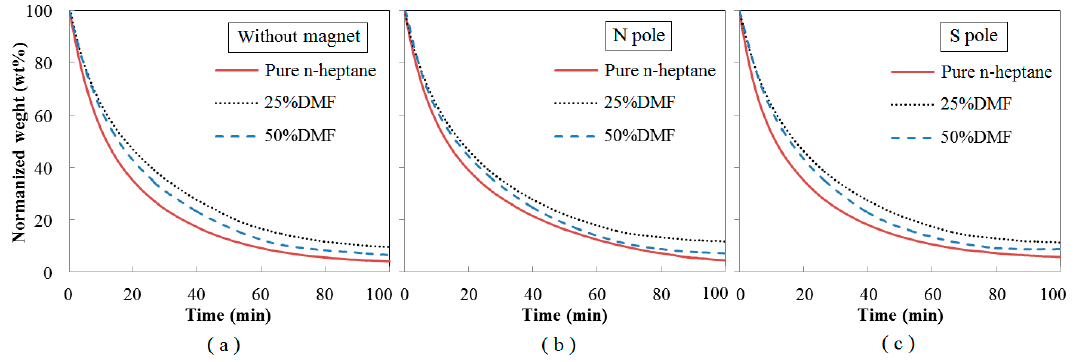
Figure 10. Comparisons of TG curves of the soot in the cases of pure n -heptane and with additions of DMF-doped.